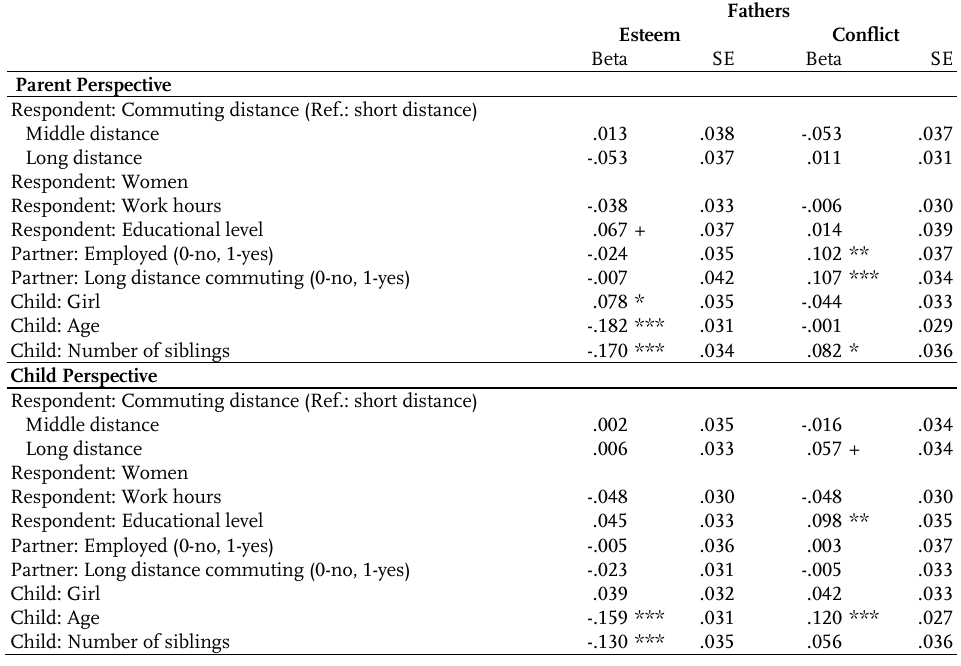
Table 4 : The association between parents’ long-distance commuting and the parent-child relationship (measured by esteem and conflict)